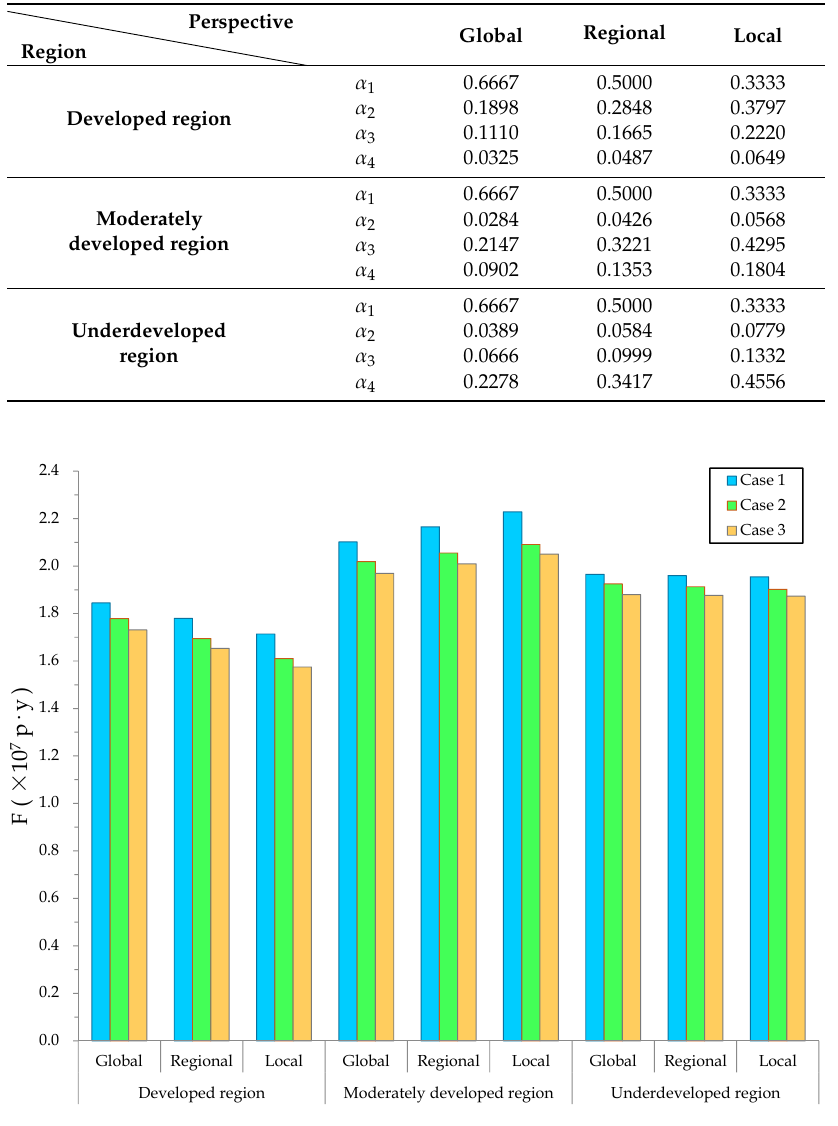
Figure 9. LCA results of CO2-eq, SO2-eq, and PM2.5-eq emissions.